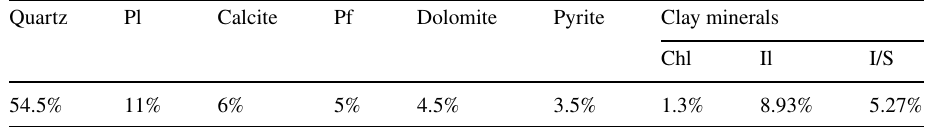
Table 2 Mineral content of the shale specimen